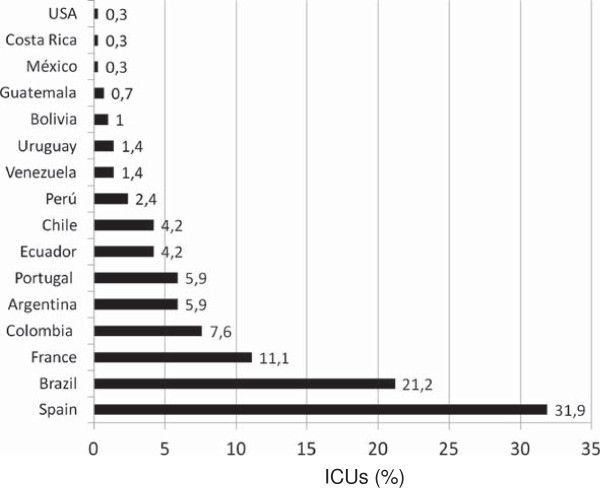
Percentage of intensive care units (ICUs) that responded to the survey out of a total of 288 responses. Data are presented according to the country of origin.